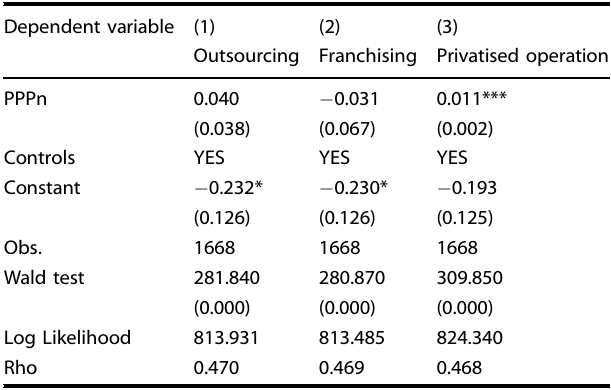
Table 6. Effect of the operation mechanism.